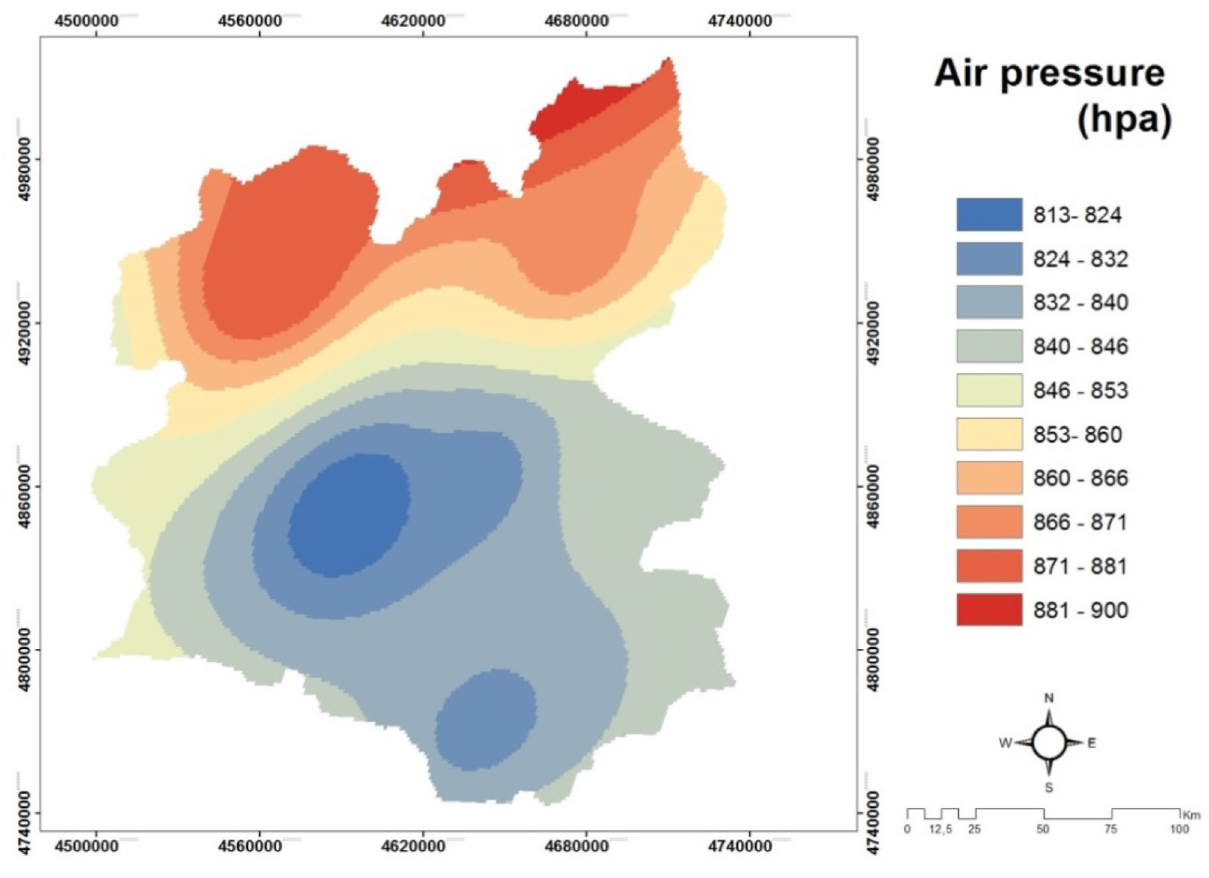
Figure 9. The air pressure map of Erzurum 20,43